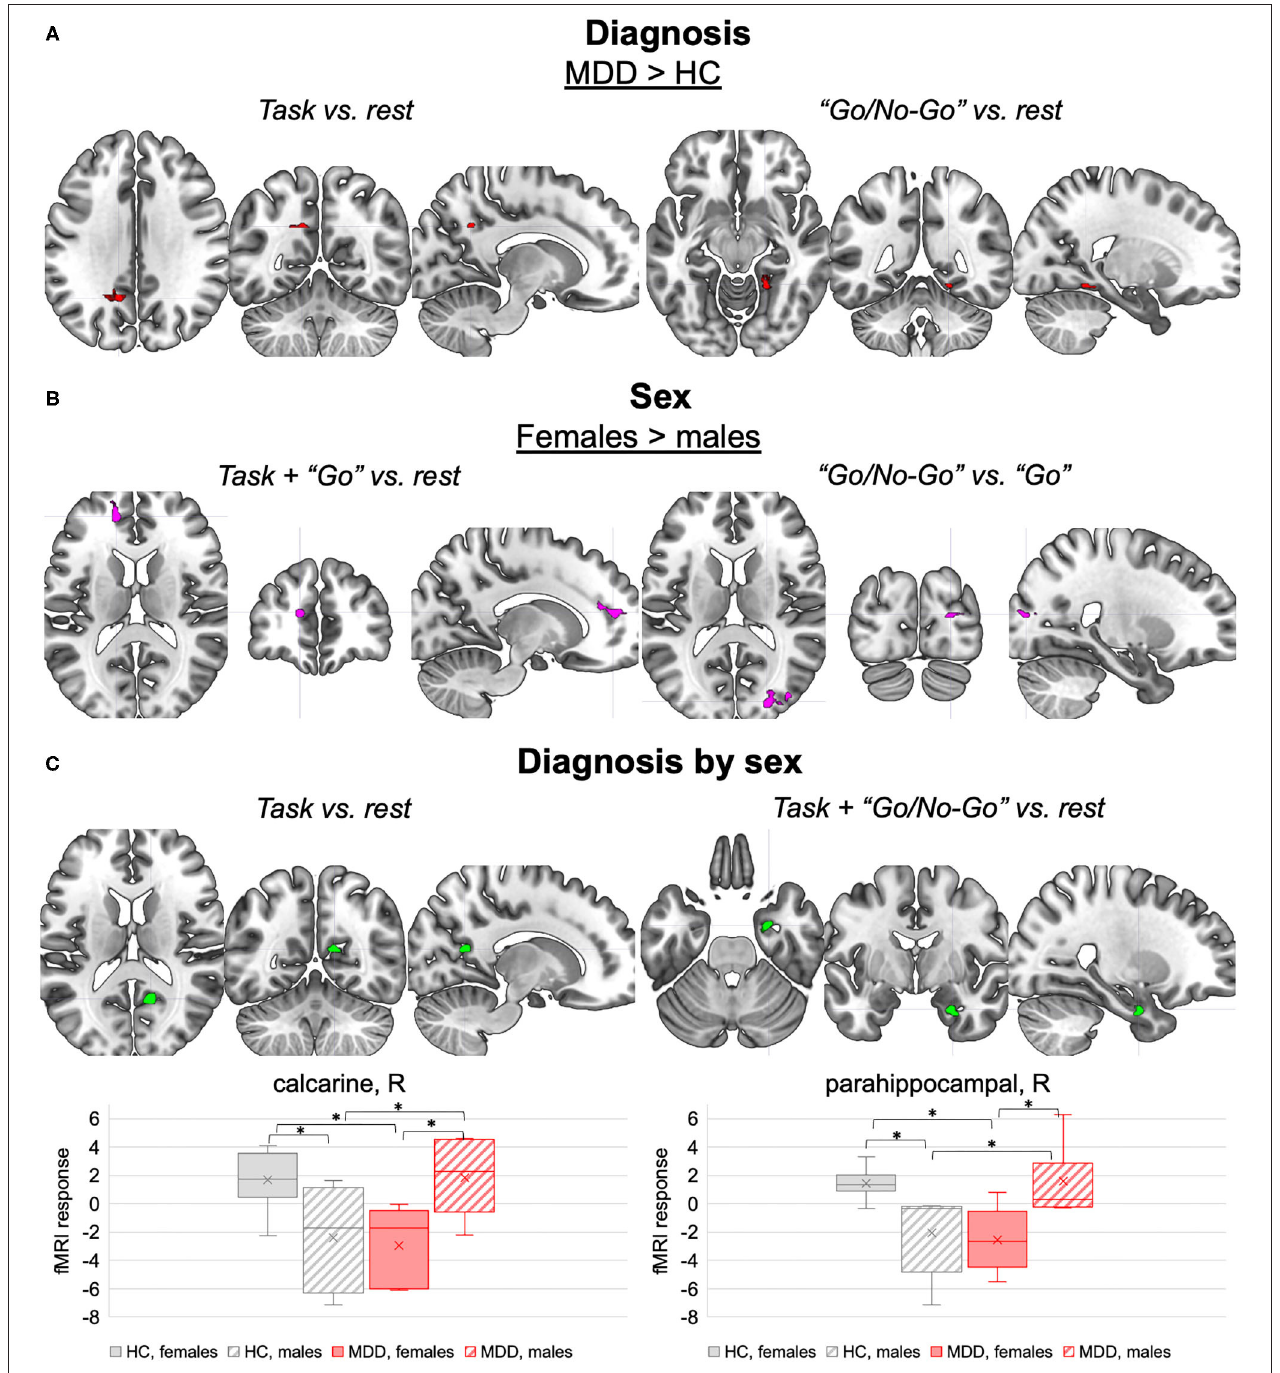
FIGURE 2 | Diagnosis, sex, and interaction effects on task-related fMRI activations. (A) Diagnosis effects. Brain clusters with different fMRI responses to the task (left panel) and to the “Go/No-Go” inhibitory blocks (right panel) in MDD compared to HC ( p < 0.001, ≥ 40 voxels). (B) Sex effects. Brain clusters with different fMRI responses to the task and “Go” excitatory blocks (left panel), and the “Go/No-Go” inhibitory blocks vs. “Go” excitatory blocks (right panel) in females compared to males ( p < 0.001, ≥ 40 voxels). (C) Diagnosis by sex effects. Brain clusters with interaction effects on fMRI responses to the task (left panel) and the “Go/No-Go” inhibitory blocks (right panel) ( p < 0.001, ≥ 40 voxels). The boxplots in the lower panel represent the corresponding normalized peak fMRI response distributions in HC females, HC males, MDD females, and MDD males. Pairwise differences in the peak fMRI response between diagnosis by sex subsets (net of age) are highlighted ( p < 0.05). MDD, major depressive disorder; HC, healthy controls; L, left; R, right. *significant pairwise differences ( p < 0.05).